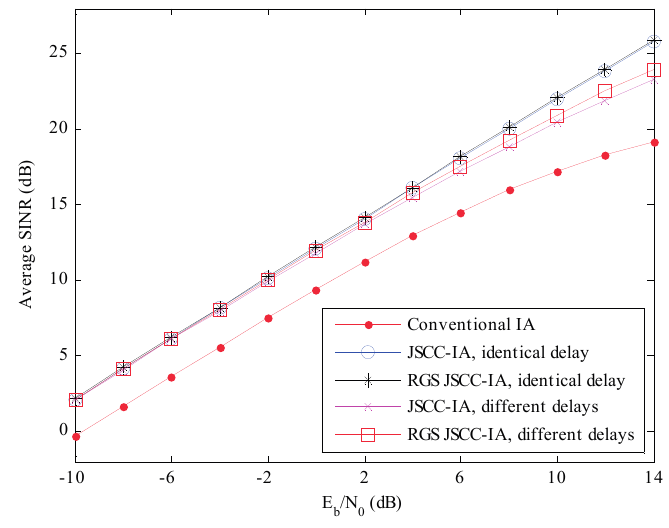
Figure 16. The average received SINR of the conventional IA scheme, the JSCC-IA schemes with identical/different propagation delays and the RGS JSCC-IA schemes with identical/different propagation delays in the (6 × 6, 2) 18 asymmetric